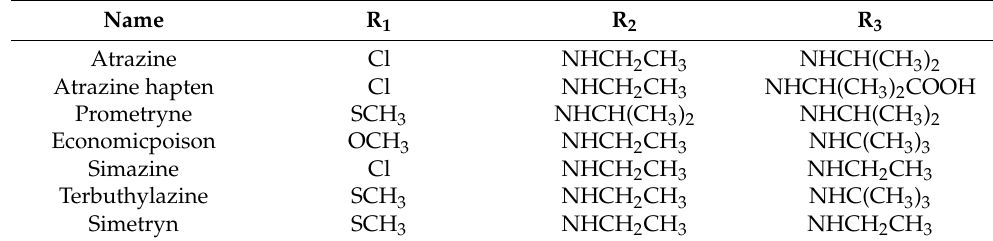
Table 6. Molecular formula of atrazine and triazine herbicides with cross-reaction. Table 7. Comparison with previously reported atrazine hapten structures and cross-reaction rates.